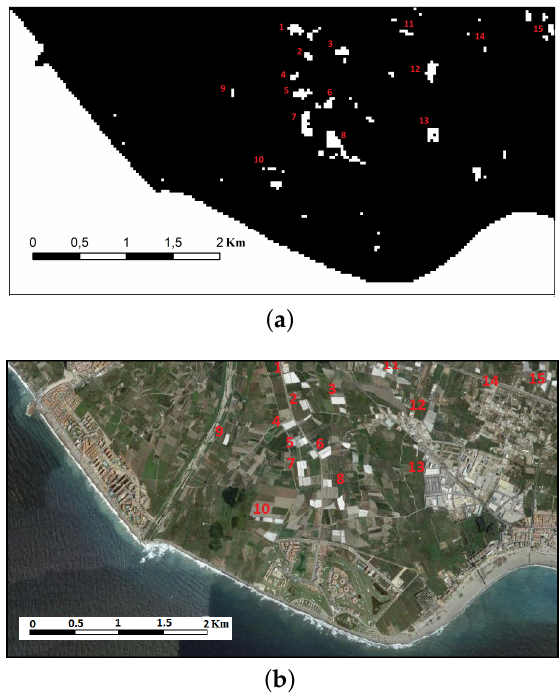
Figure 13. Comparison of the locations of some of the greenhouses in the delta plain of the Guadalfeo River. ( a ) The greenhouses detected with WI2 in an OLI Image captured on 12 September 2013. ( b ) The greenhouses on a Google image from 31 December